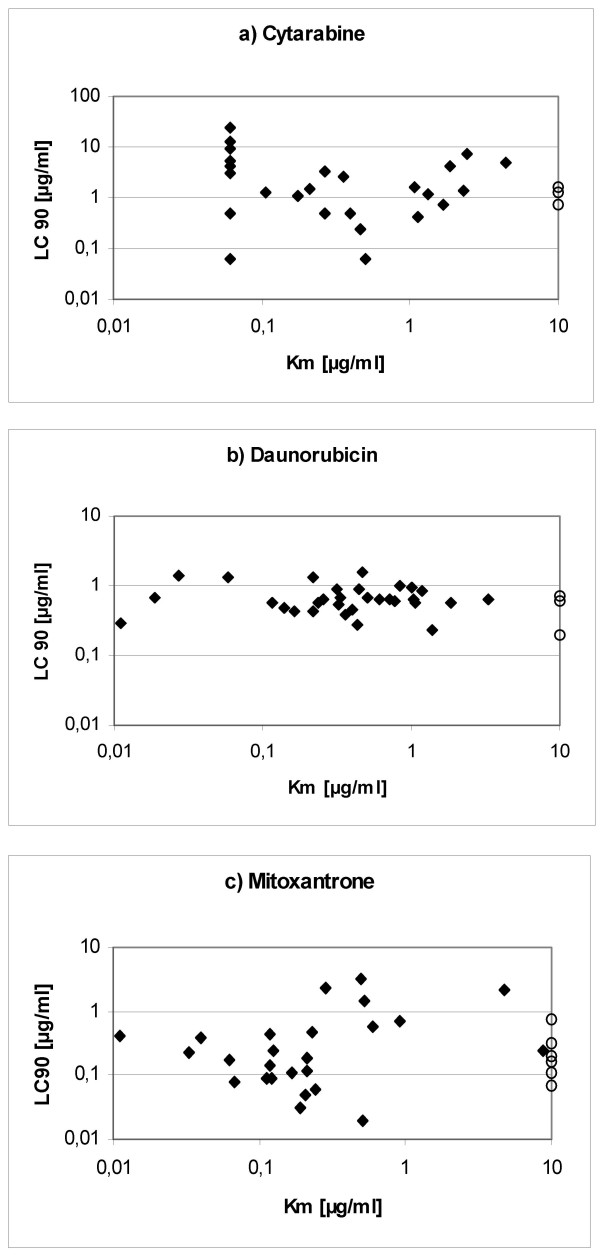
Distribution of the LC90- (DiSC-assay) and Km-values (Casp3-test) for the tested drugs a) cytarabine (N = 33), b) daunorubicin (N = 36), and c) mitoxantrone (N = 33).